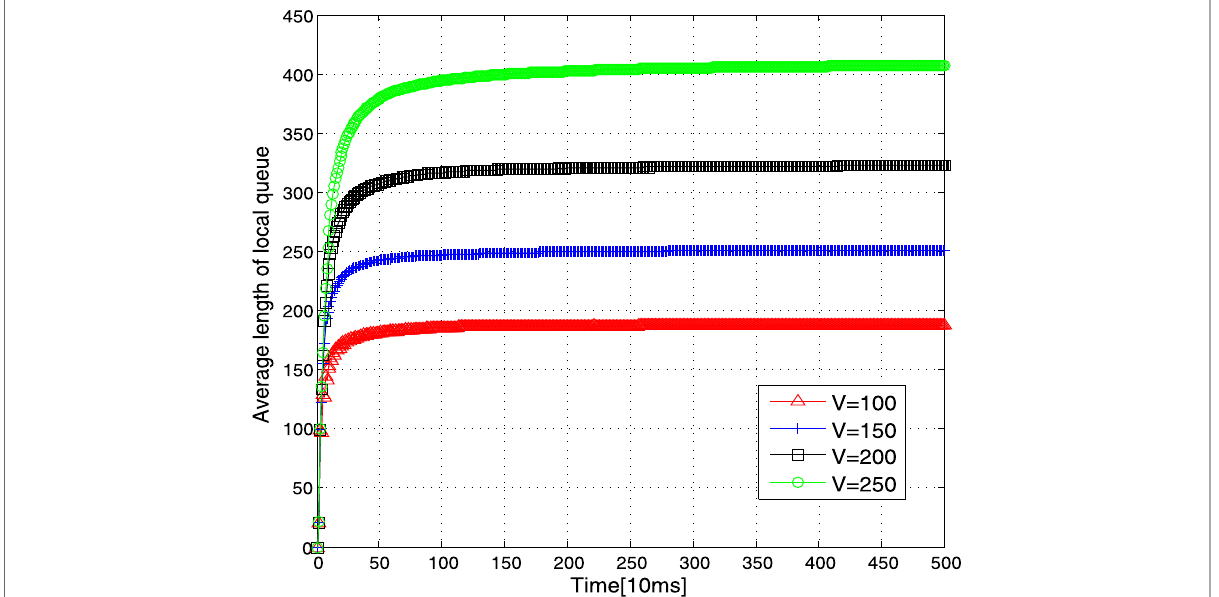
Fig. 12 The average length of the local queue versus time with different